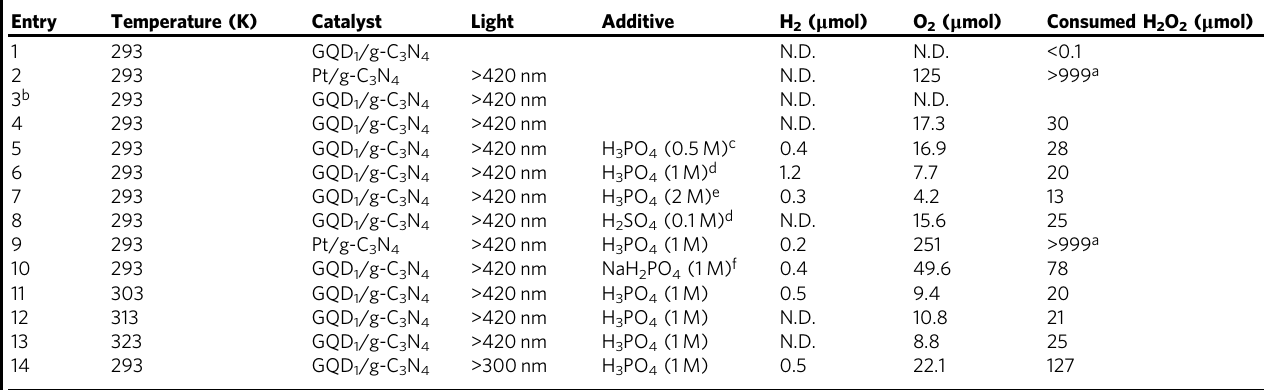
Table 1 Results of photocatalytic H 2 O 2